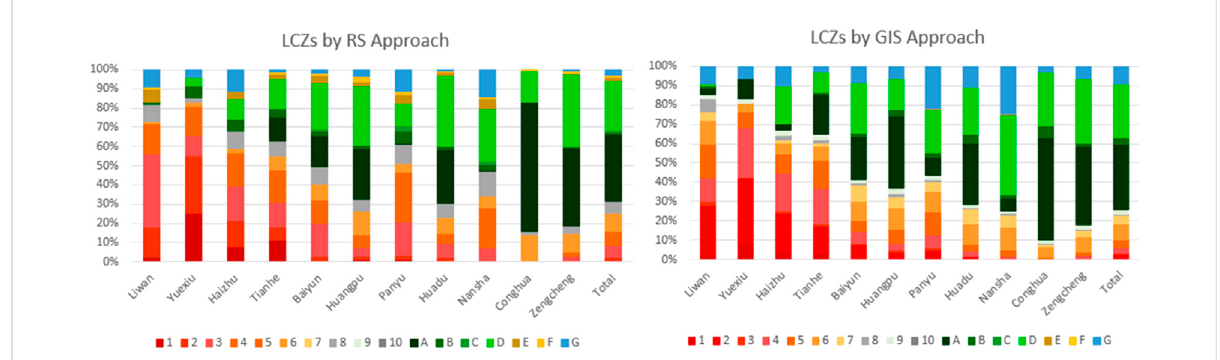
FIGURE 5 The proportion of LCZ sorted by districts in Guangzhou using RS- (left) and GIS-(right) based approaches.